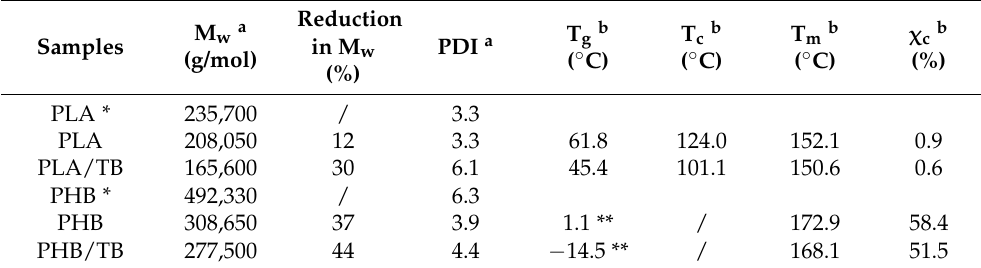
Table 2. Molecular and thermal characterization data of neat and plasticized PLA and PHB.